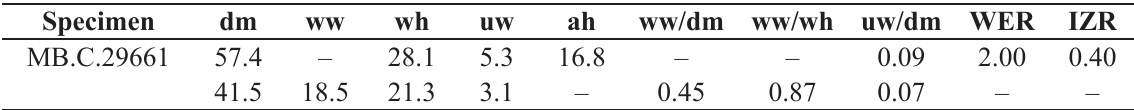
Table 1. Conch dimensions (partly estimated) and ratios of a specimen of Pseudogastrioceras relicuum Korn & Ghaderi in Korn et al. , 2016 from Baghuk